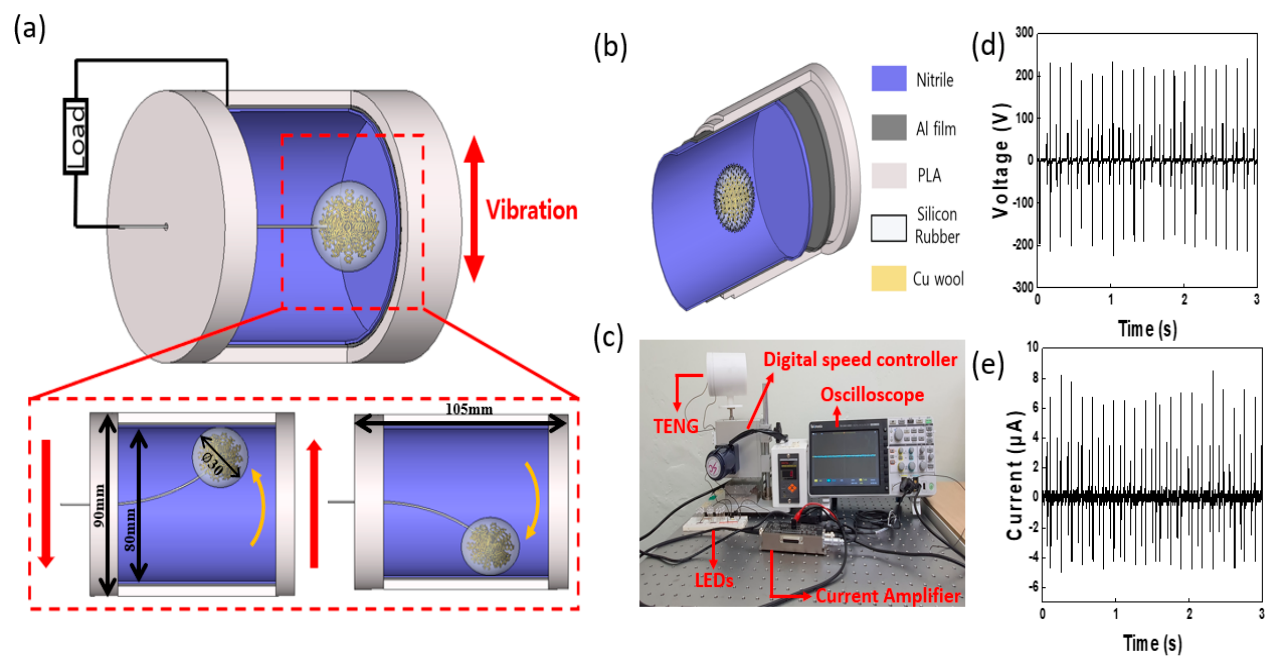
Figure 1. Schematic and experimental configuration of a triboelectric nanogenerator (TENG). ( a ) Schematic and movement of the TENG in a dynamic state, ( b ) material composition of the TENG, ( c ) photograph of the configuration of the experimental equipment, ( d ) plot of the output voltage, and ( e ) plot of the output current of the TENG. PLA: polylactic acid.